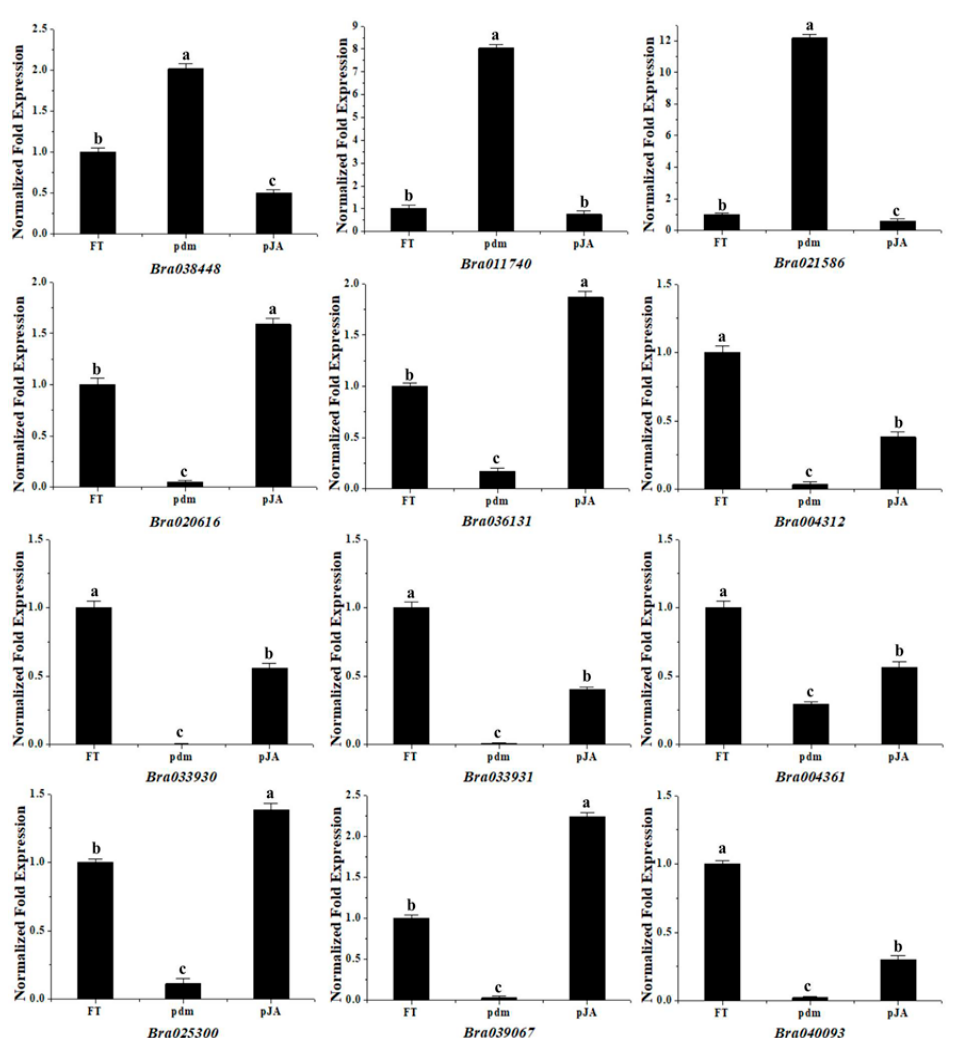
Figure 5. qRT-PCR analysis of gene expression patterns. Note: The relative expression levels of 12 differentially expressed genes.